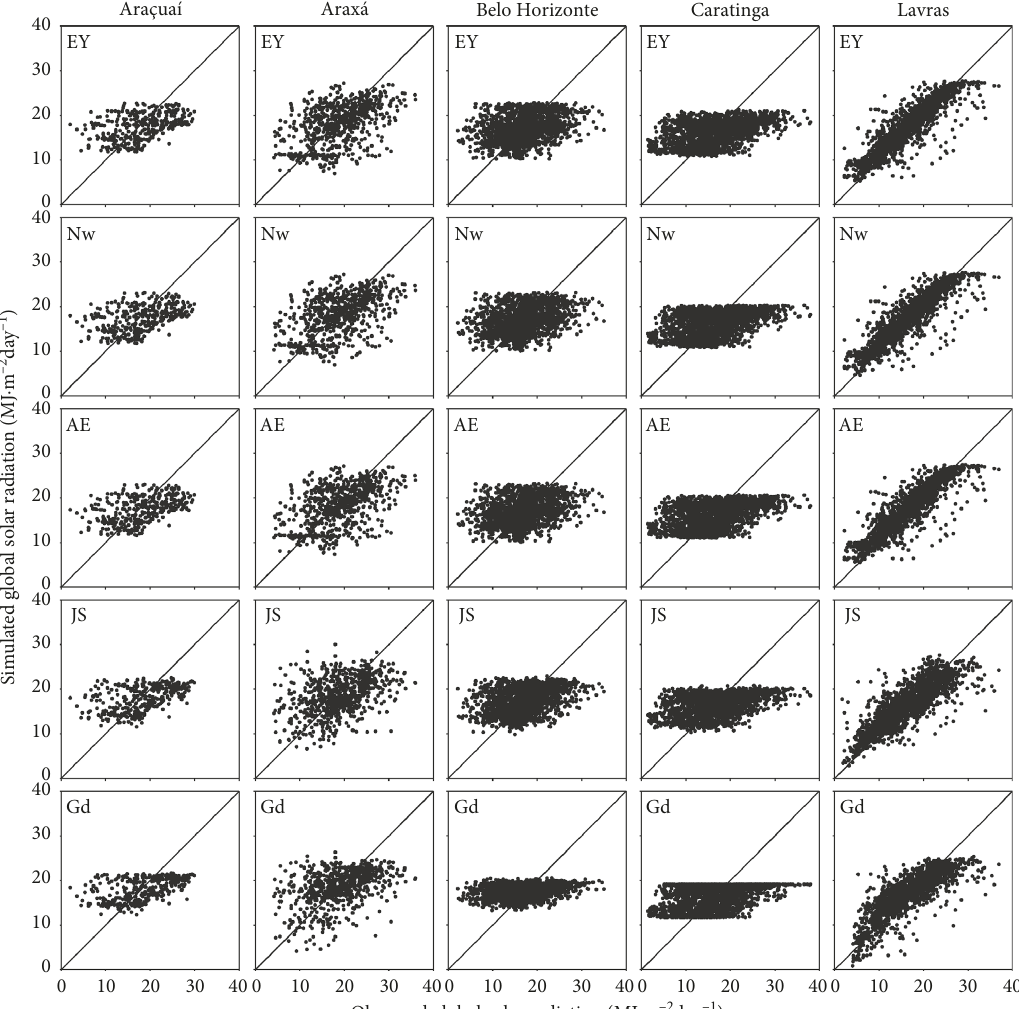
Figure 3: Simulated versus observed global solar radiation (MJ · m − 2 day − 1 ) for the five models that presented the best fit (EY: Ertekin and Yaldiz, 2000; Nw: Newland, 1989; AE: Akinoglu and Ecevit, 1990; JS: De Jong and Stewart, 1993; and Gd: Goodin et al., 1999) for Araçua´ı, Arax´a, Belo Horizonte, Caratinga, and Lavras. The filled-in line refers to line 1